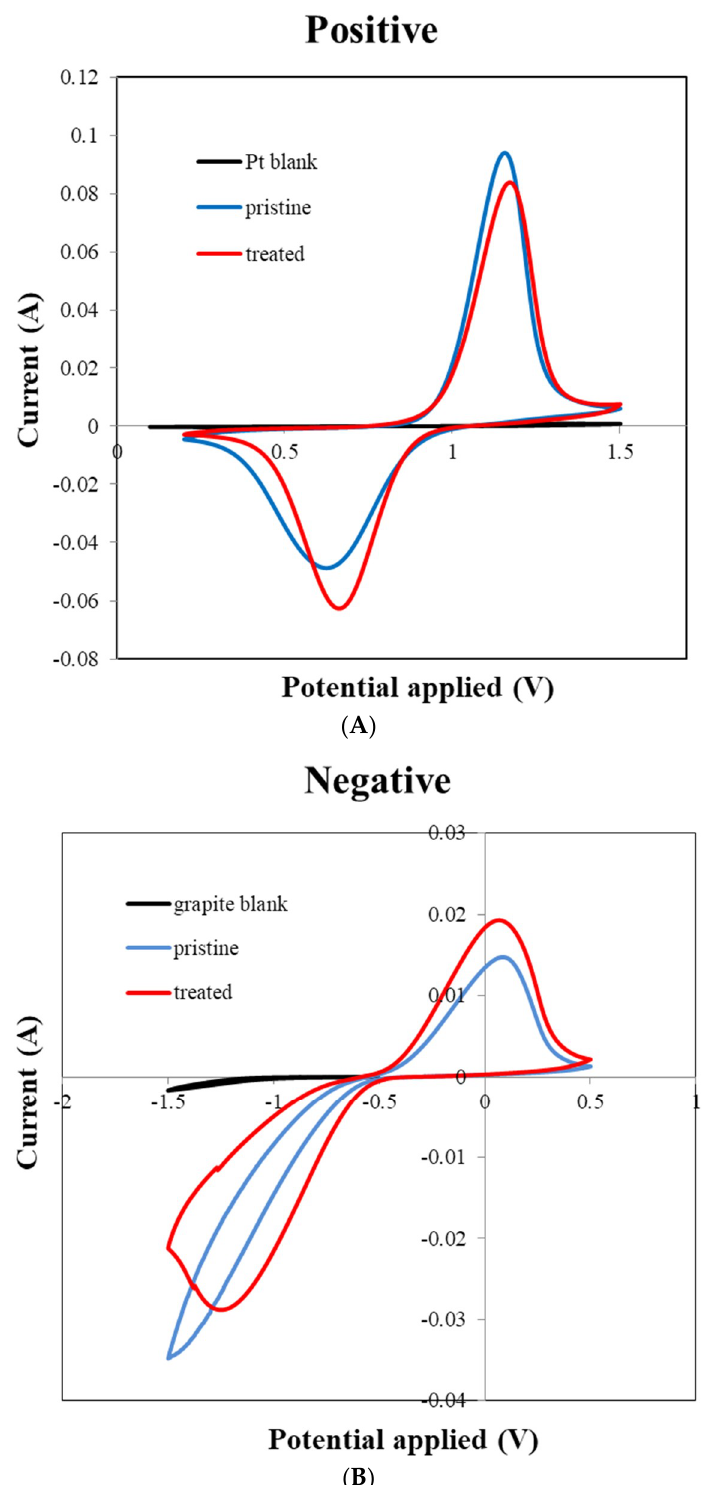
Figure 6. Cyclic voltammetry (CV) results of ( A ) positive electrodes ( B ) negative